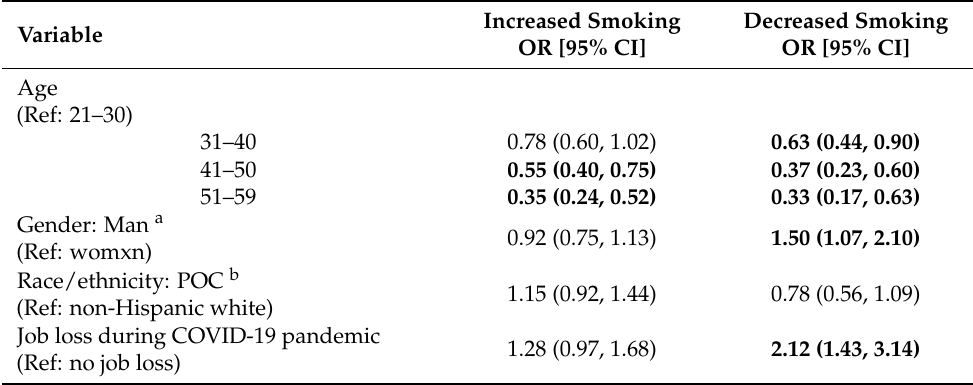
Table 4. Changes in smoking and COVID-related perceptions among adults who smoke daily and have not had COVID-19 in 30 U.S. cities (N =